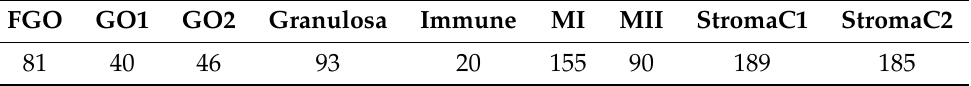
Table 1. The number of single cells within individual cell types included in Dataset 1.